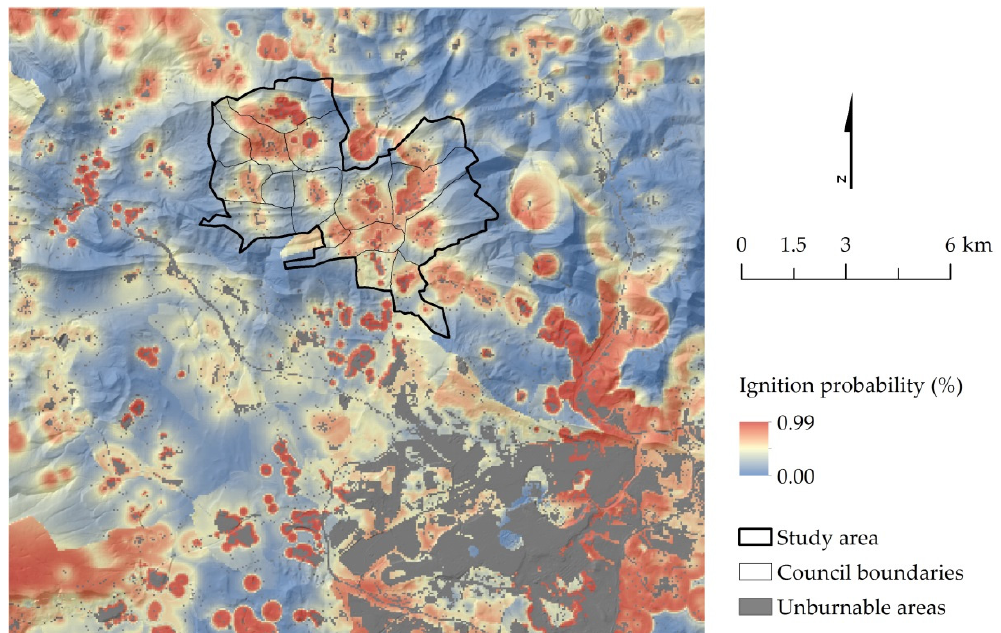
Figure 4. Ignition probability grid generated with an artificial neural network using the geospatial variables associated with the observed ignition data (1985 to 2013 historic fire records; mapama.gob.es). This fire occurrence grid was used to generate the 10,000 fire ignition input data masked to burnable fuels in the wildfire modeling domain. Unburnable areas ( IP = 0) correspond to urban development, roads and water bodies.